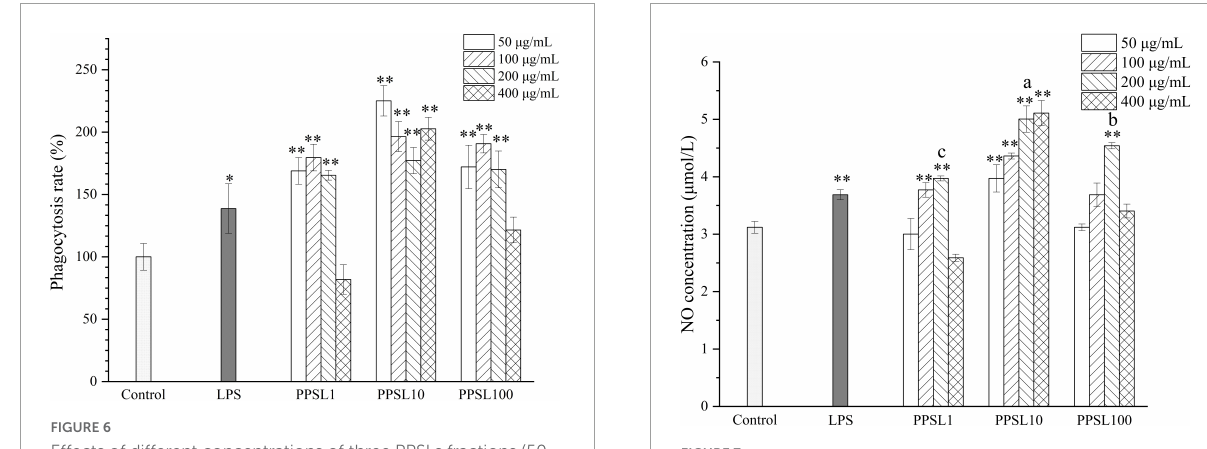
FIGURE7 Effects of different concentrations of three PPSLs fractions (50, 100, 200, and 400 µ g/mL) on NO production of RAW264.7 macrophages. ** p < 0.01 vs. control group. The different letters (a, b, c) showed significant difference in the same concentration among three PPSLs fractions ( p <